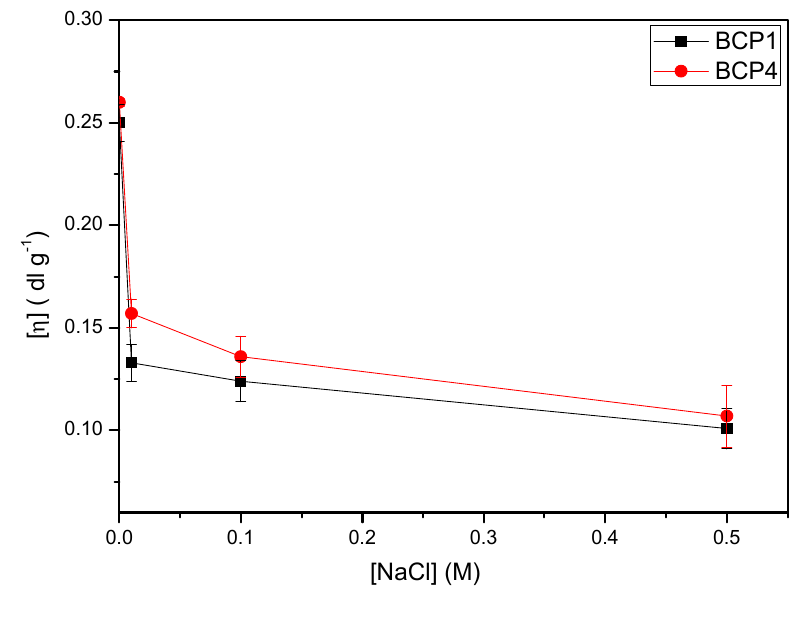
Figure 9. Effect of NaCl concentration on the intrinsic viscosity of copolymers BCP-1 and BCP-4 measured at 25